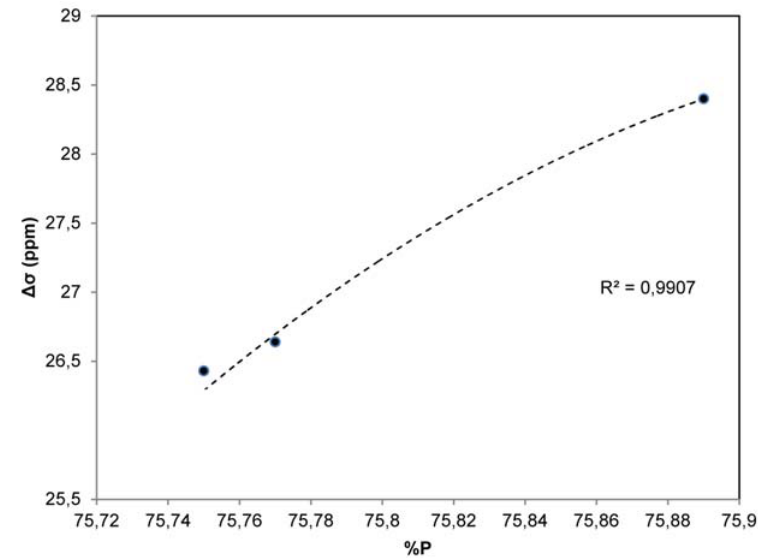
Figure 5. Correlation between percent of P orbital and Δσ in threonine hydrochloride